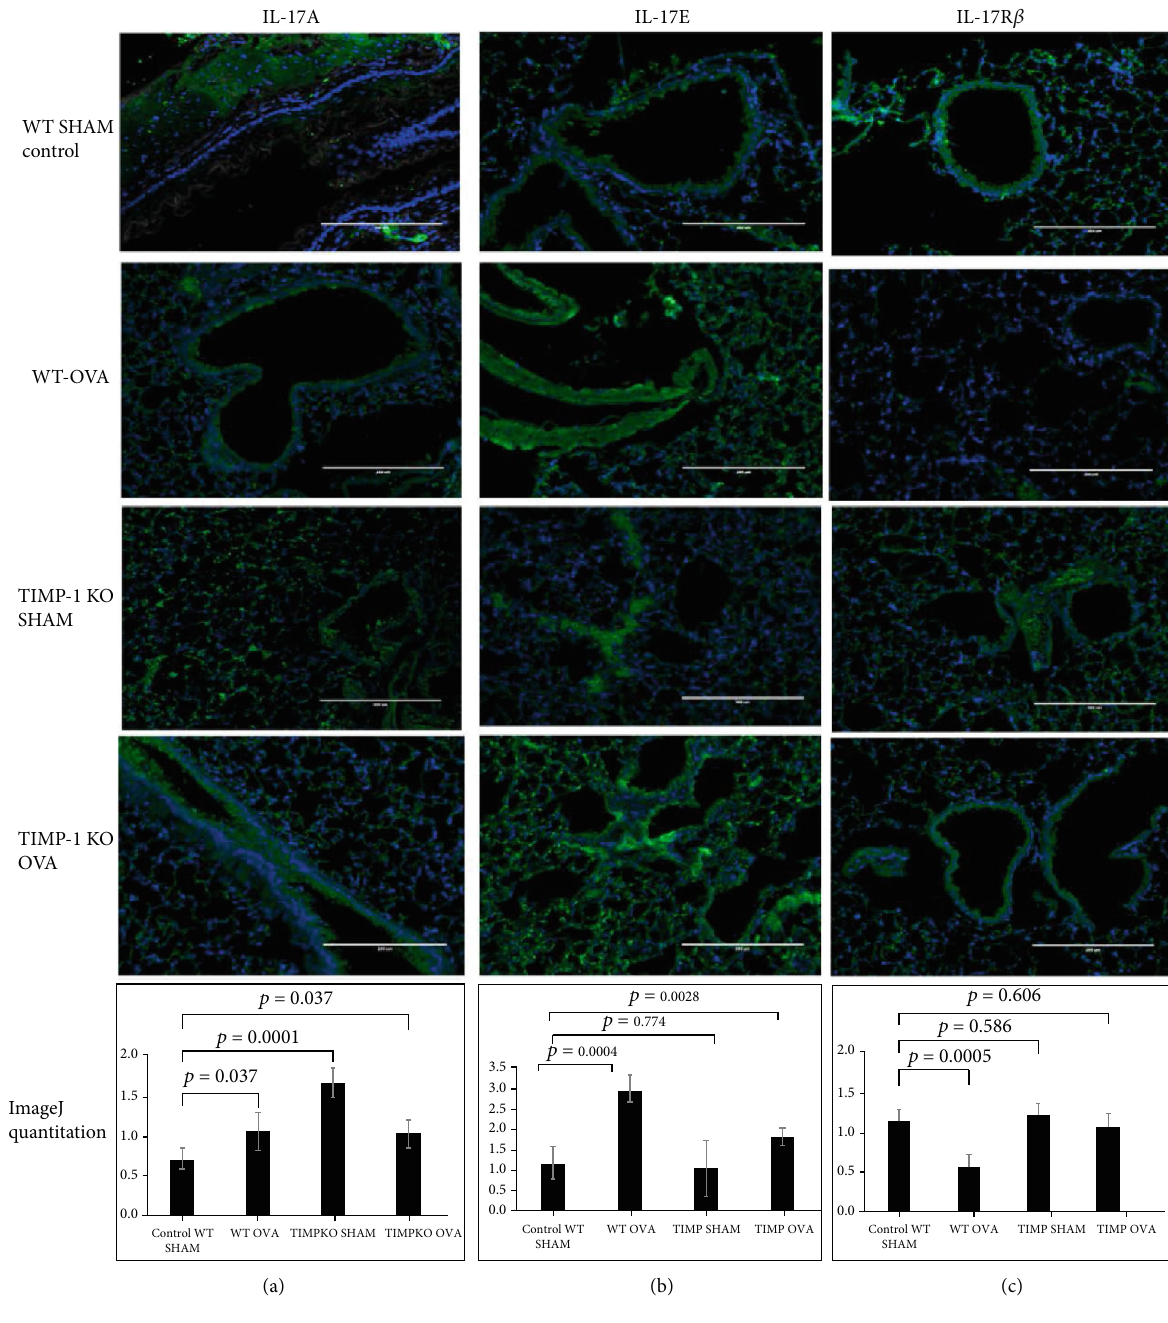
Figure 5: IL-17A, IL-17R β , and IL-17E expression in lung tissue obtained OVA-sensitized TIMP-1 K/O, OVA-sensitized TIMPKO, OVA- sensitized WT, and WT-SHAM mice. Representative images of immuno fl uorescent staining of IL-17A (a), IL-17E (b), and IL-17R β (c). The fl uorescent intensity is quantitated using the ImageJ software, and the representative histogram derived from n = 3 separate experiments with WT-SHAM as